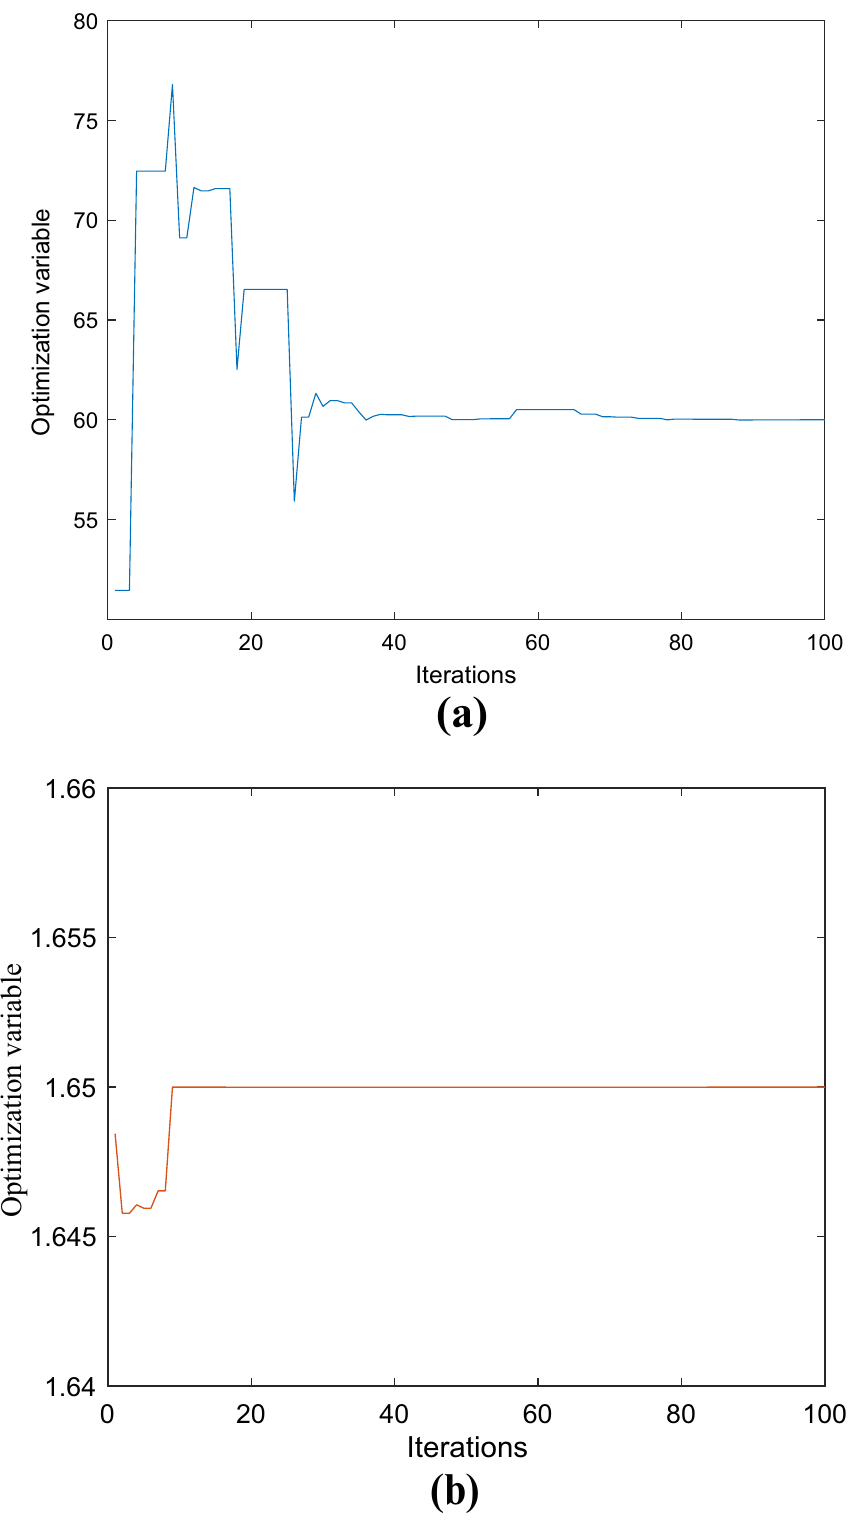
Figure 15. Iterative curve of depth angle and depth